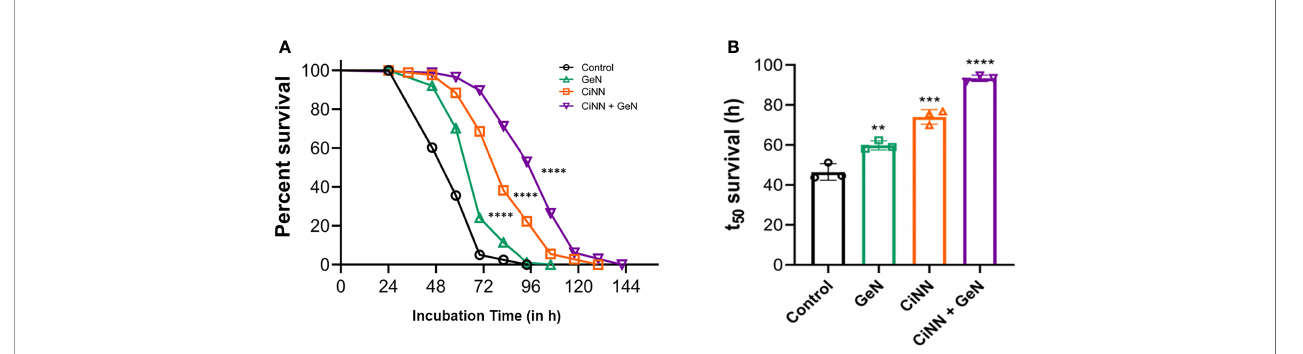
FIGURE 9 | Anti-virulence effect of CiNN and GeN against PAO1 infection in C. elegans . (A) Percent survival of PAO1-infected C. elegans from slow-killing assays in the presence and absence of CiNN and GeN at sub-MICs, alone and in combination. (B) Comparative analysis of worm lifespan in terms of t 50 survival values following drug treatment (**p ≤ 0.01, ***p ≤ 0.001, ****p